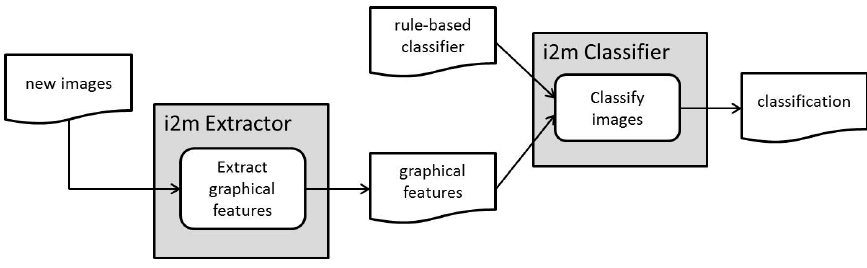
Figure 13. Application stage: classifying new images with the generated rule-based classifier